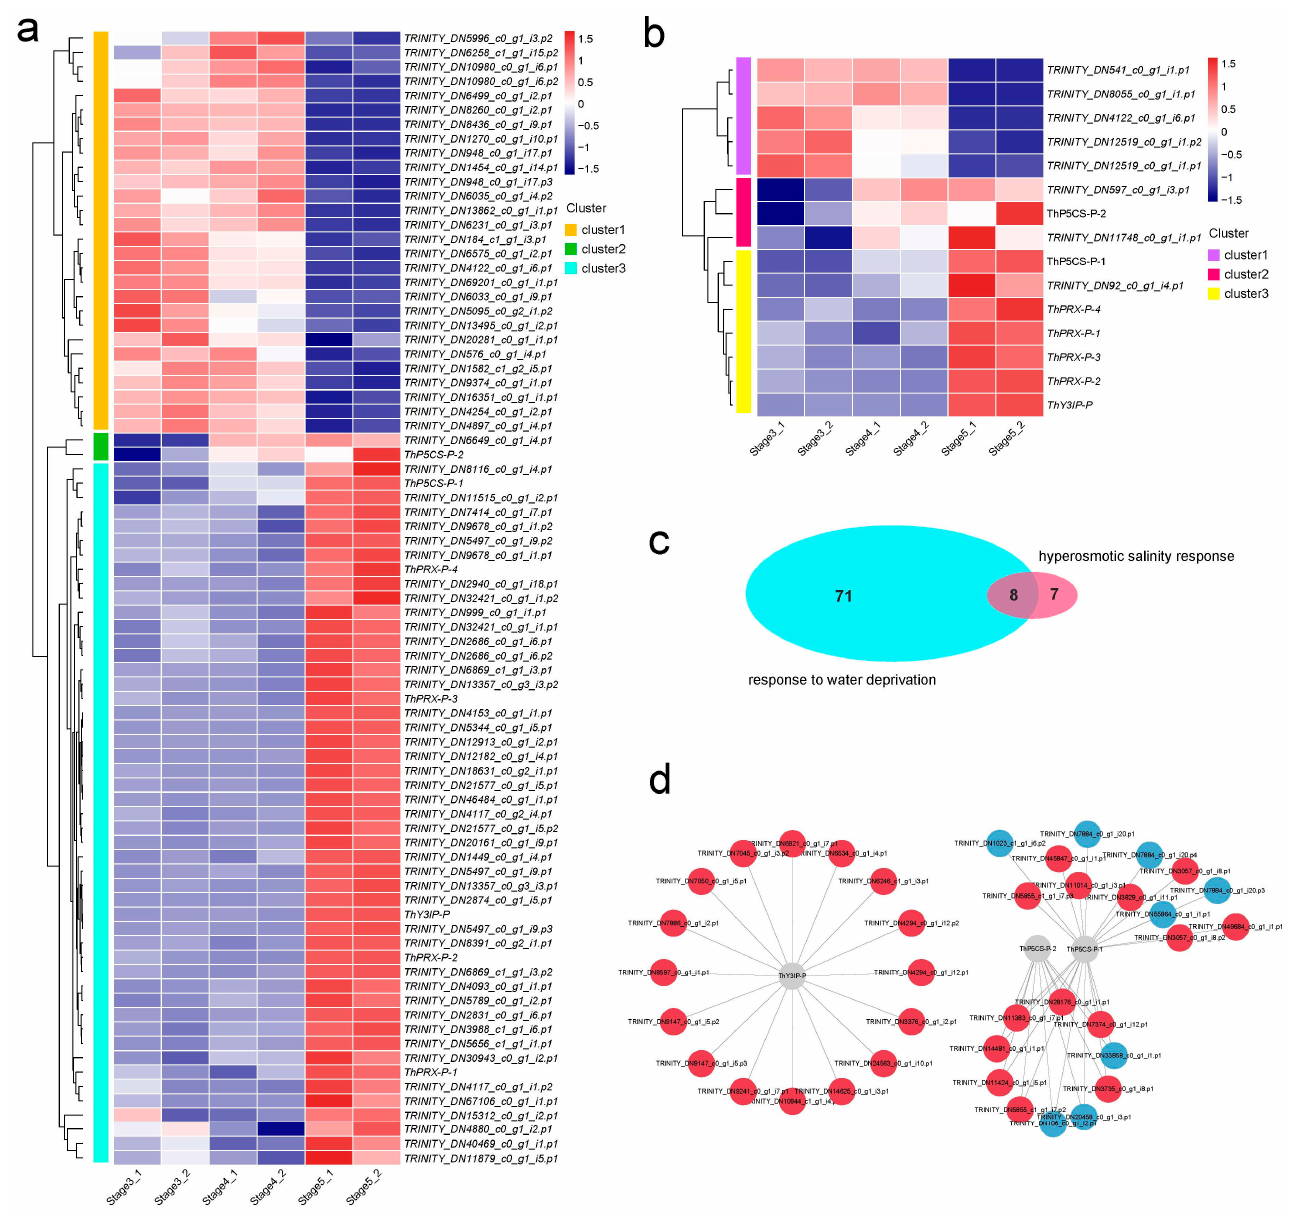
Figure 6. Abundance analysis of DAPs based on proteomics. ( a ) Heat map of water-deprivation- response-associated DAPs. ( b ) Heat map of hyperosmotic-salinity-response-associated DAPs. ( c ) Venn plot between response to water-deprivation-associated DAPs and hyperosmotic-salinity- response-associated DAPs. ( d ) Analysis of the functional network by STRING 11.0 of DAPs tied to responses to both water deprivation and hyperosmotic salinity. Red indicates significantly upregu- lated DAPs, and blue indicates significantly downregulated DAPs.